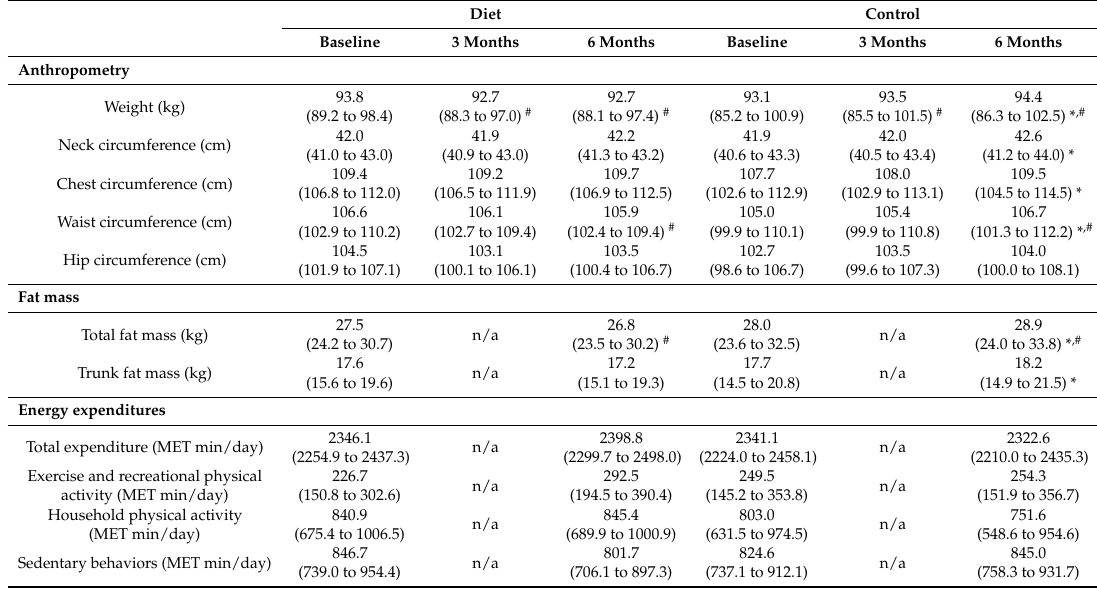
Table 2. Anthropometry, fat mass, and energy expenditures at baseline and follow ‐ ups.